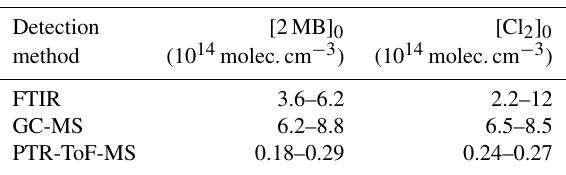
Table 2. Initial concentrations of 2MB and Cl precursor in the re- actor.